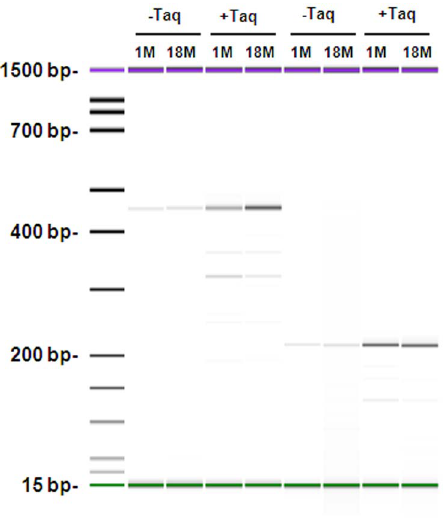
Figure 4. Level of RNA Deletions is Age-Independent. Intentional capture of mtRNA deletions by PCR amplification of extended cDNA regions.